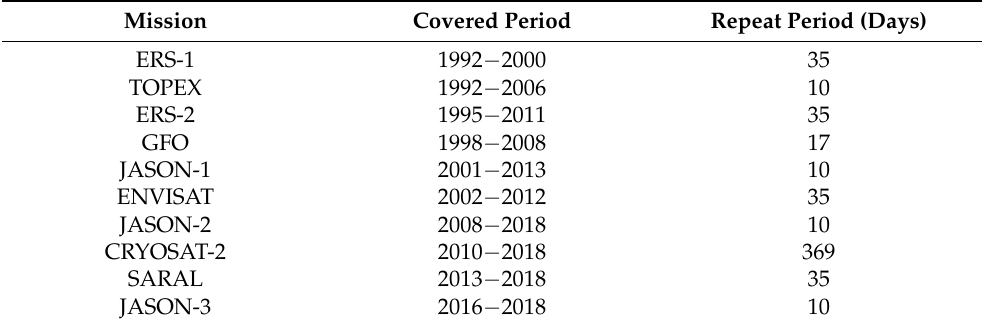
Table 1. Altimeter missions used for the Sea State CCI dataset for the time interval 1992–2018 (information processed from